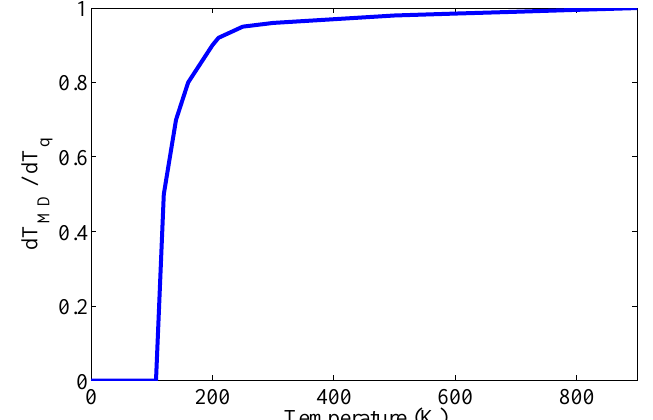
Figure 2. Rate of change of MD temperature with respect to Quantum Corrected temperature versus MD temperature for